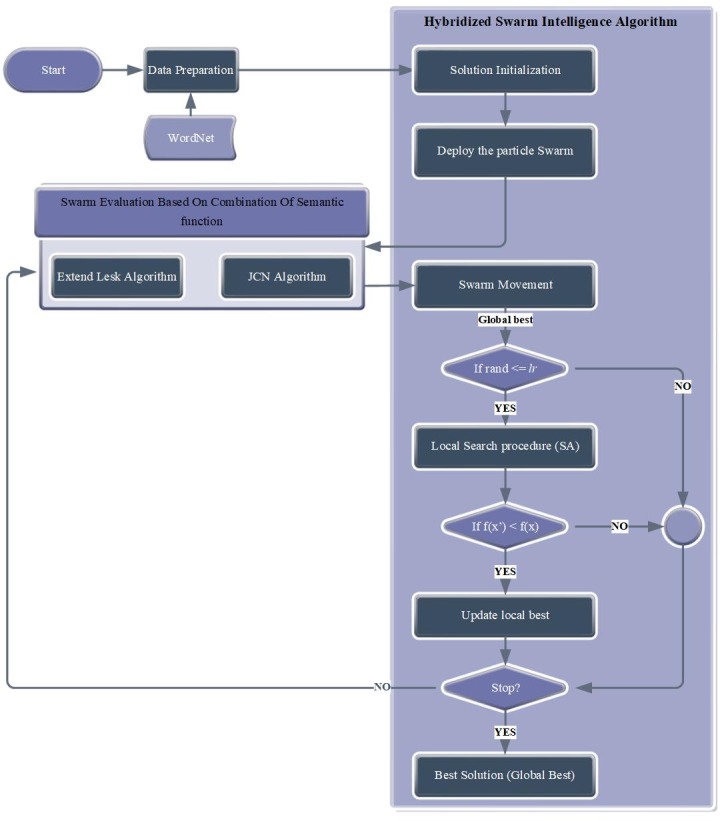
Proposed technique.